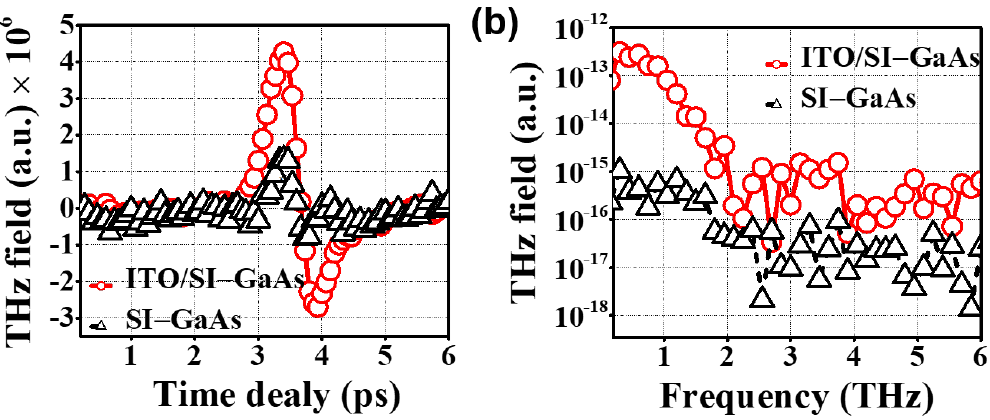
Figure 6. ( a ) THz waveforms and ( b ) corresponding spectra of THz radiation emitted by the bare SI − GaAs substrate and ITO/GaAs sample at low pump intensities.